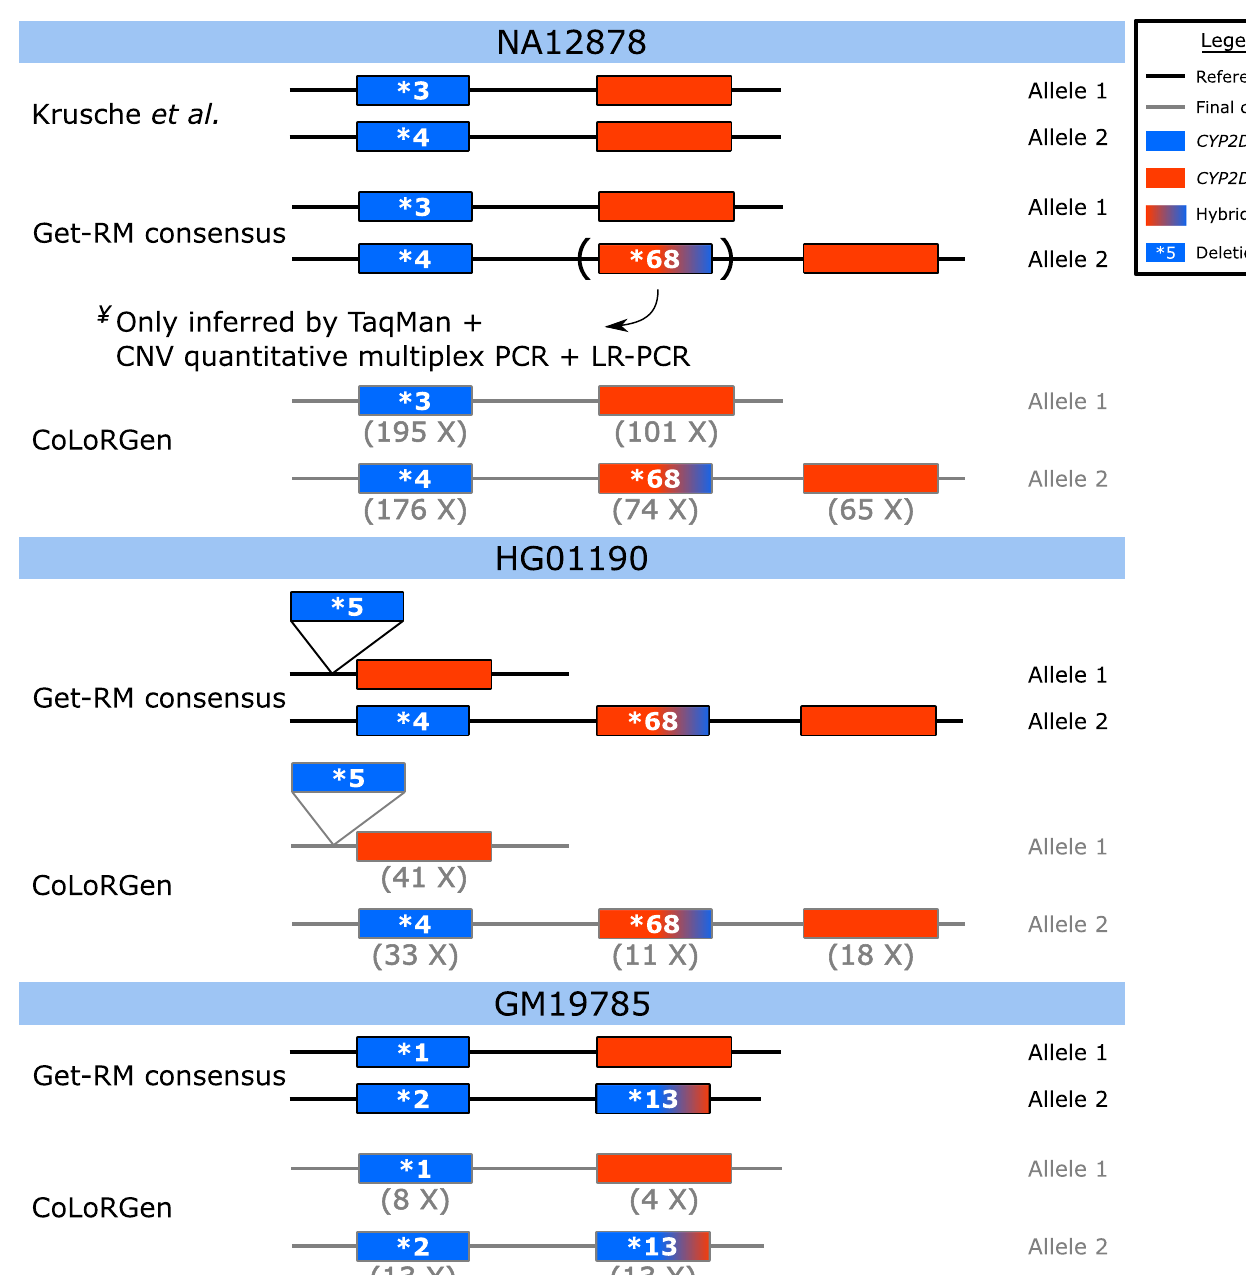
Fig 4. Star-alleles in literature references and star-alleles assigned by the CoLoRGen pipeline. Reference star-alleles were obtained from Krusche et al. [36] and the Get-RM studies [15,16].The depths mentioned below the genes are the generated average depths on that position of the locus. ¥ The � 68 allele was only detected when TaqMan-based genotyping was combined with CNV and structural variant detection using quantitative multiplex PCR and LR-PCR validation. Therefore, the Get-RM consensus star-allele only mentions the � 68 allele in brackets. Note: even when depths below the minimal 16X depth for reliable small variant calling were obtained, correct star-alleles could be